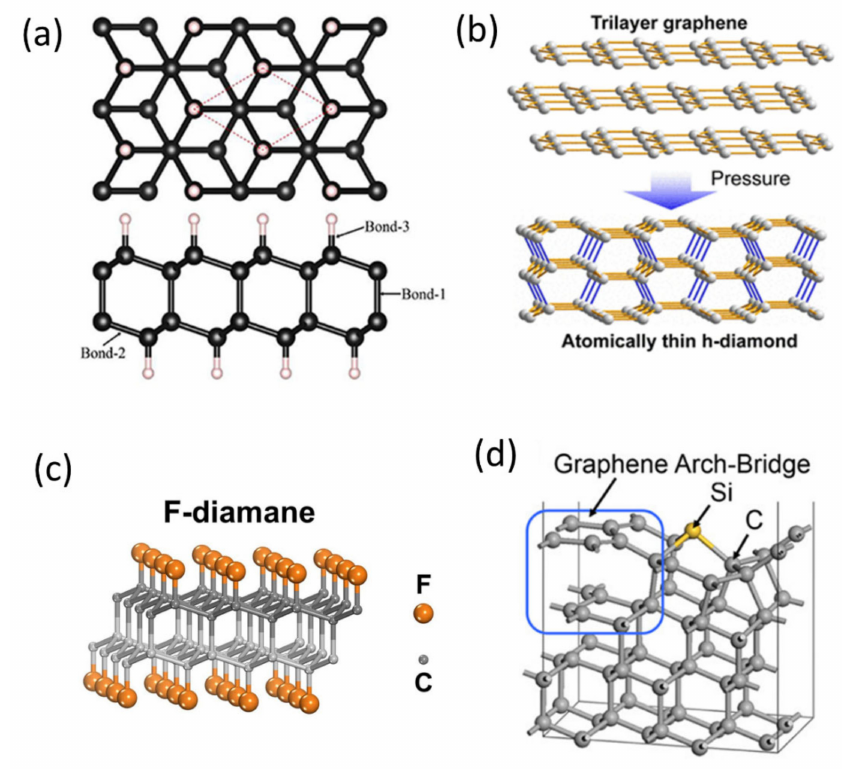
Figure 2. Examples of graphene—diamond transformations at nanoscale. ( a ) fully optimized structure of diamane. Reprinted with permission from [53]. Copyright 2020 IOP Publishing. ( b ) Pressure-induced graphene to H-diamane transformation. Reprinted with permission from